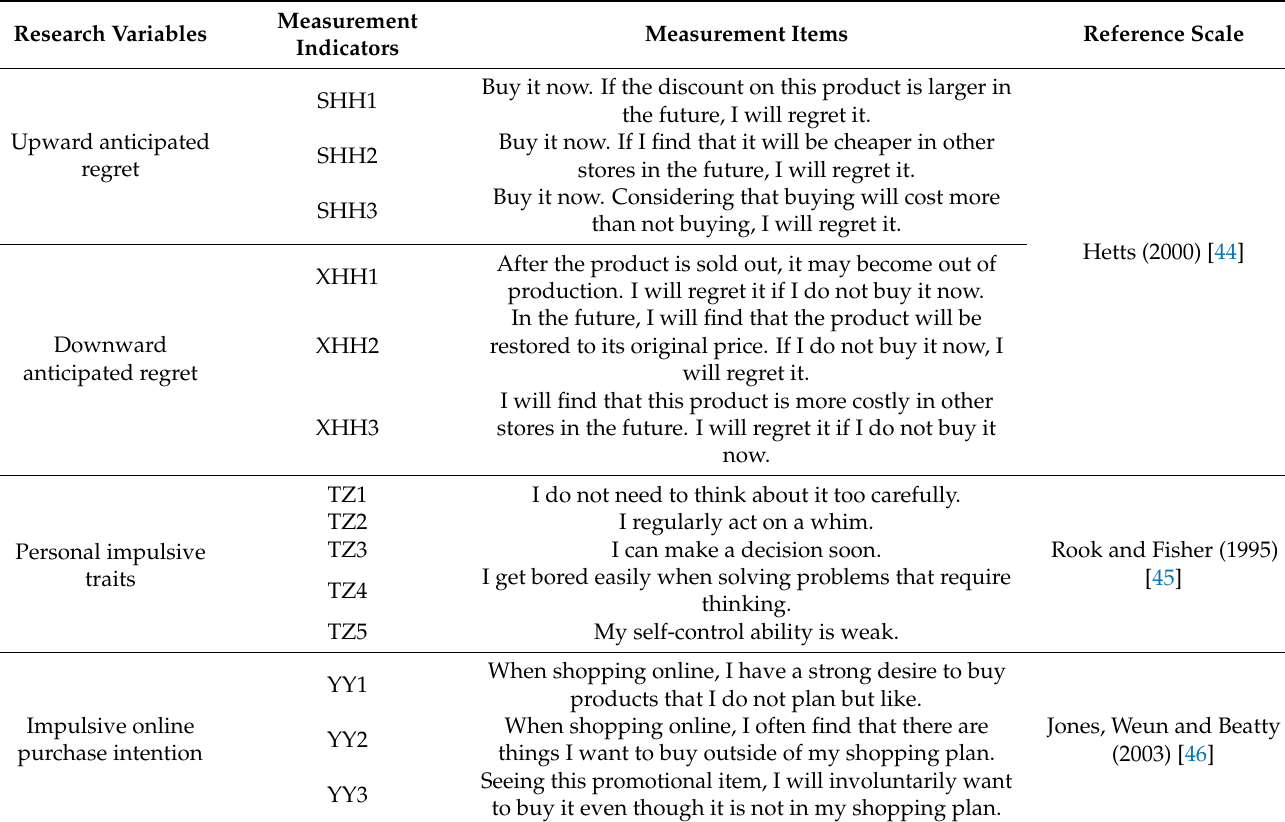
Table 1. Research variable measurement